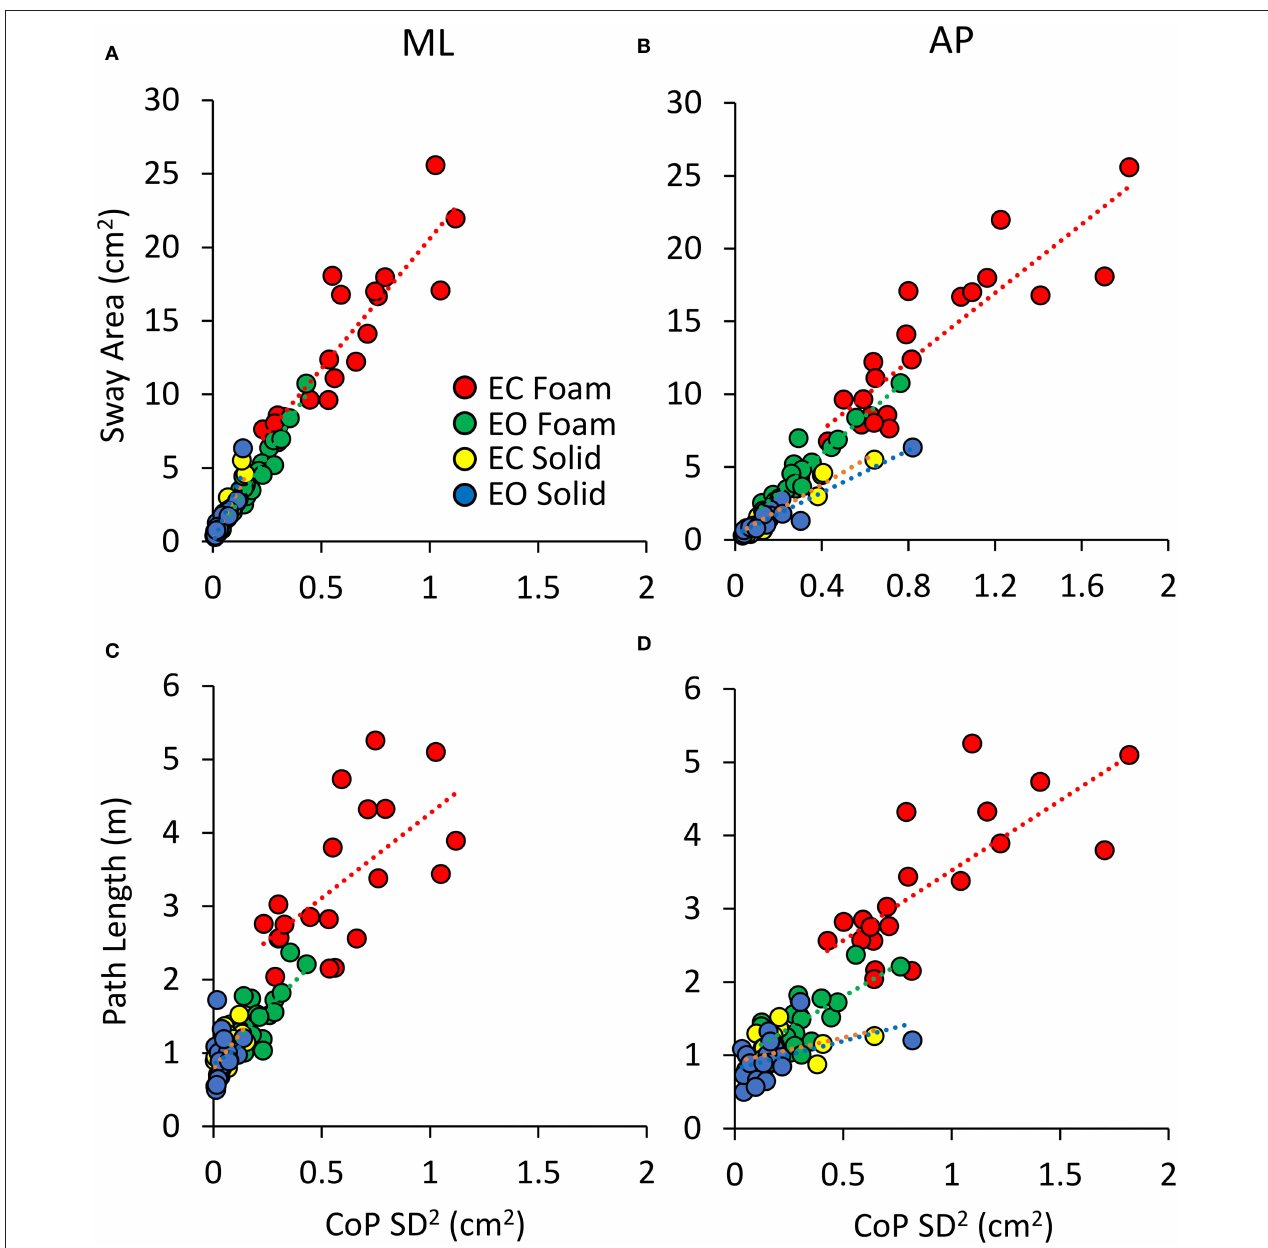
FIGURE 5 | Relationship between geometric measures and variance of the CoP excursions. Sway Area (A,B) and Path Length (C,D) are plotted against the CoP variance (SD 2 ) for both ML (A,C) and AP directions (B,D) for all visual and support conditions. Each dot corresponds to a subject. The association with CoPSD 2 is stronger for Sway Area than for Path